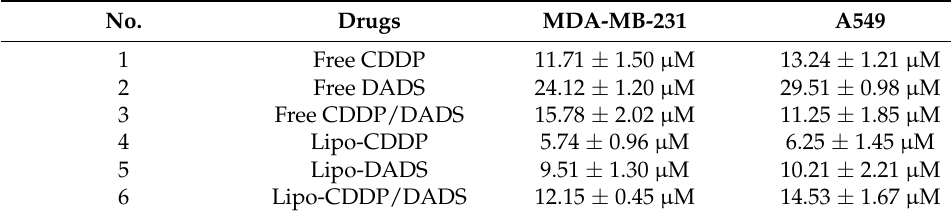
Table 4. IC 50 values for free and nanoliposomal drugs on cancer cells by MTT assay.